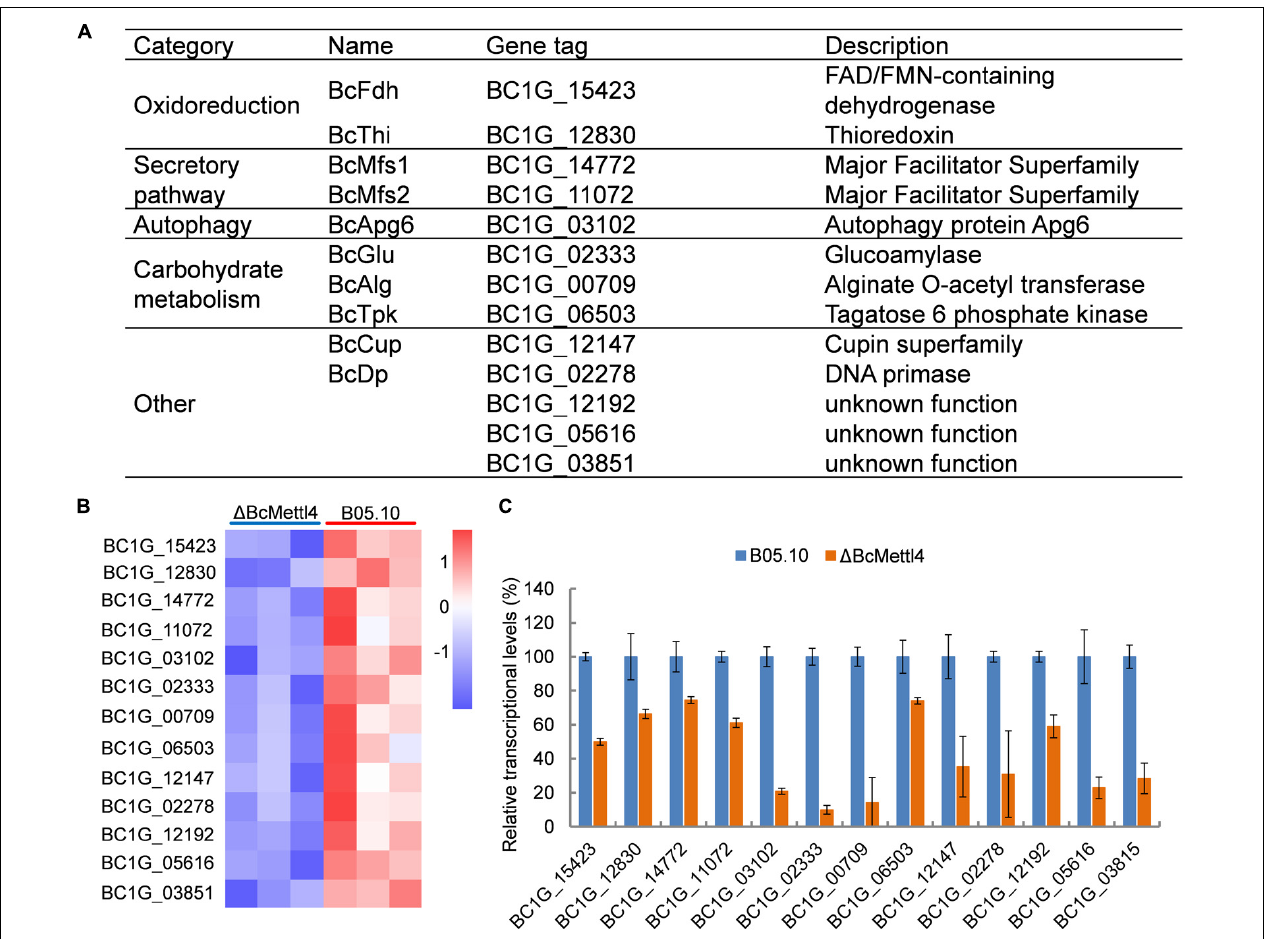
FIGURE 7 | The downregulated methylated genes in which modification occurs in the promoter region. (A) Categories of the screened genes. (B) RNA-Seq analysis of 13 methylated genes. The colored squares show the level of gene expression referred to log2 FPKM value in each of the three replicas. (C) Validation of RNA-Seq data of selected genes by fluorescent real-time qRT-PCR. The reference gene used in this study was Beta-tubulin. Data are given as the mean ± SD, n = 3.